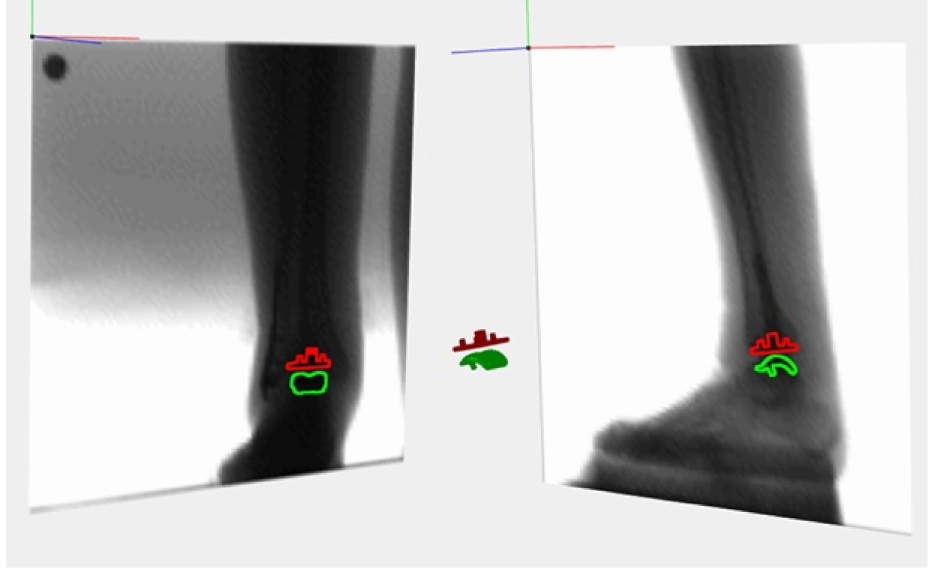
Figure 1. Example of MBRSA 3D reconstruction process of a total joint